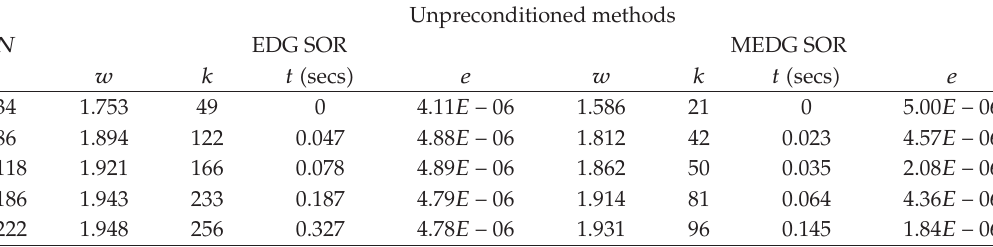
Table 1: Comparison of performances for the original EDG SOR and MEDG